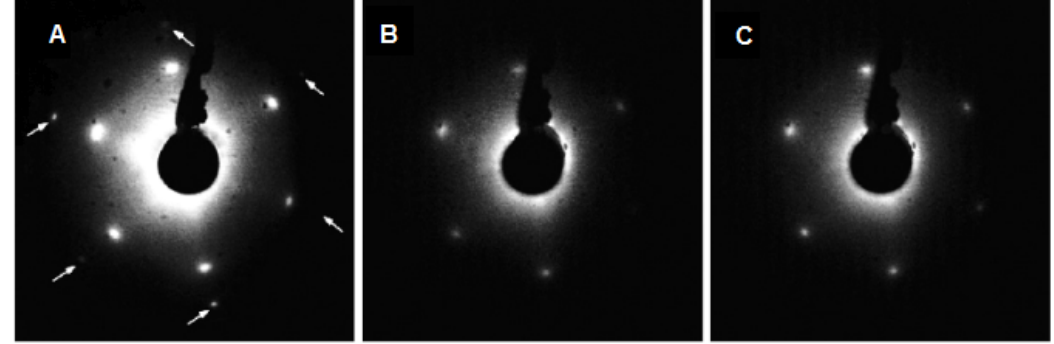
Figure 1. LEED patterns taken at the electron energy of 98 eV for various coverage of CeO 2 on Cu(111): ( A ) discontinuous film; ( B ) 2.5 ML; ( C ) 5 ML. Weak Cu(111) 1 × 1 spots are marked by the arrows [35]. Copyright Elsevier 2008.